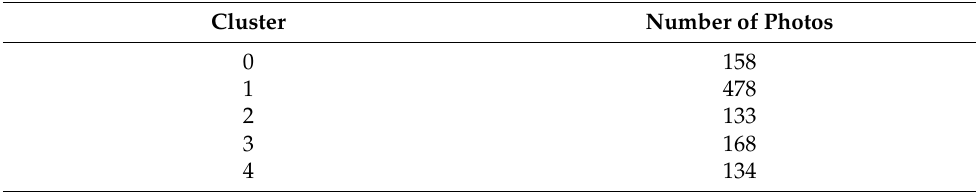
Table 4. Number of training photos by category in Insadong.